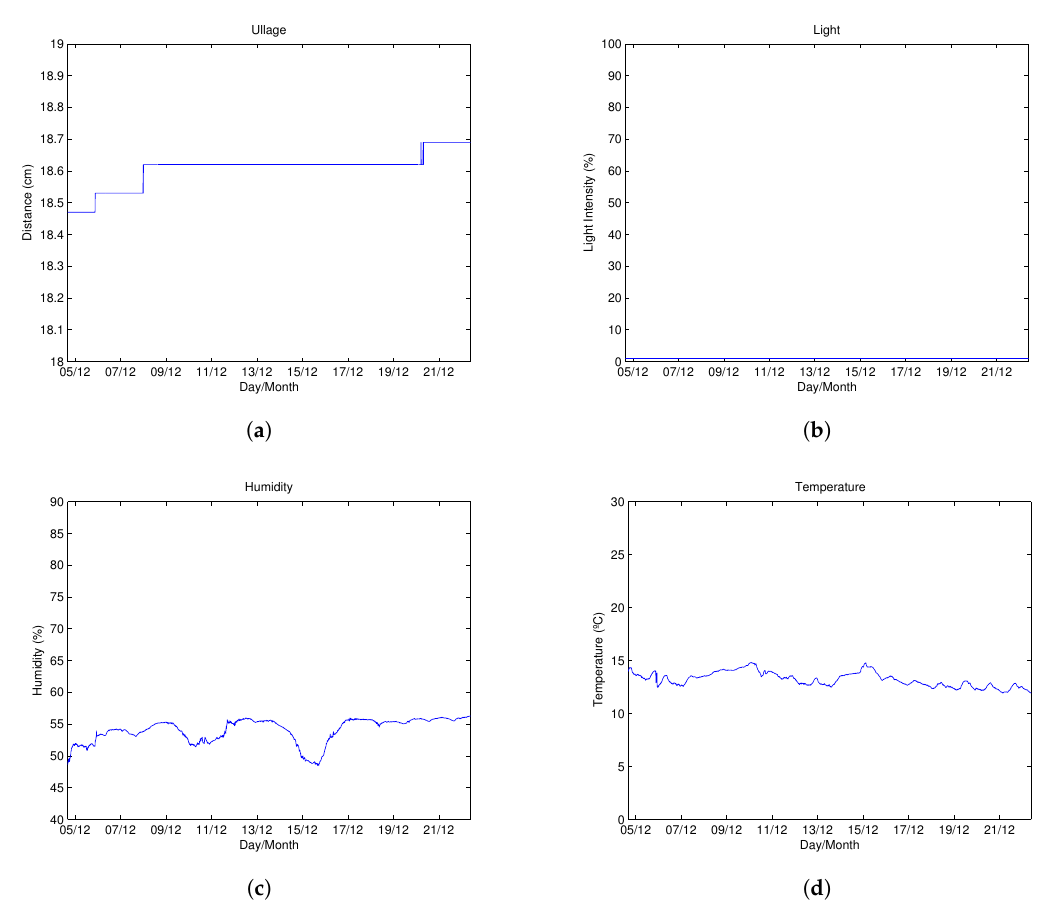
Figure 11. Wine cellar sensor readings. ( a ) Ullage (cm). ( b ) Light intensity (%). ( c ) Humidity (%). ( d ) Room temperature ( ◦ C).